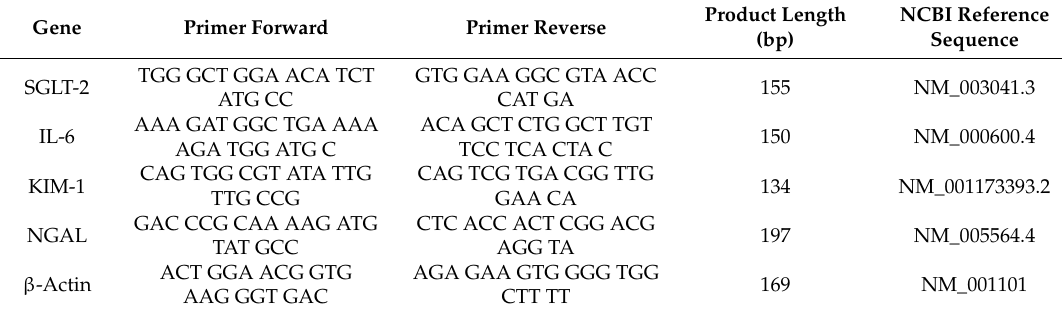
Table 1. Primer used for PCR